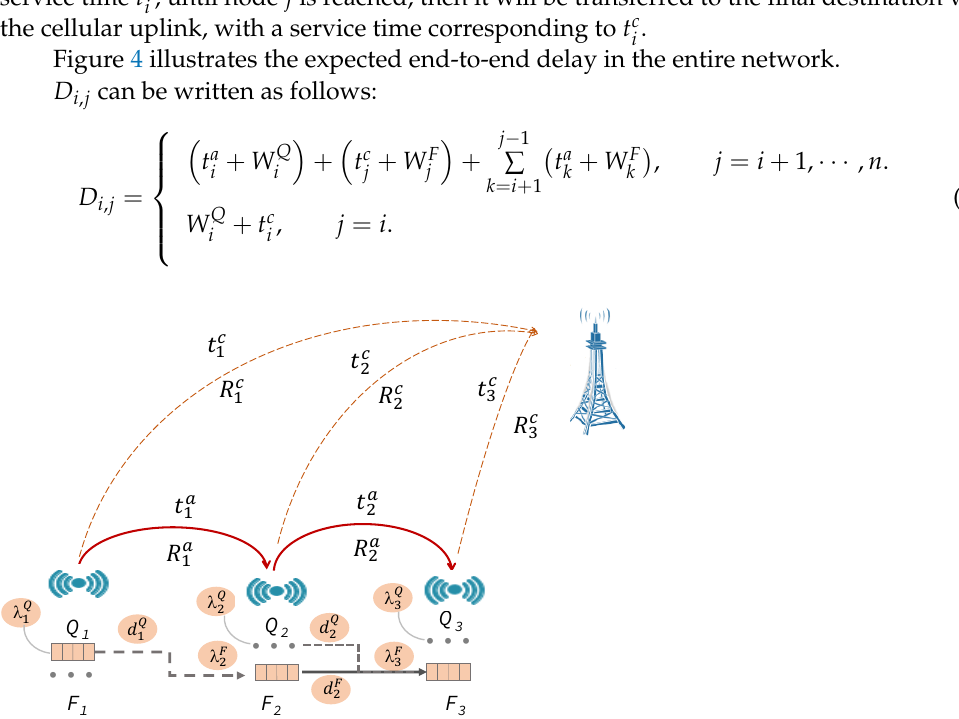
Figure 4. Expected end-to-end delay over two-tier IoT